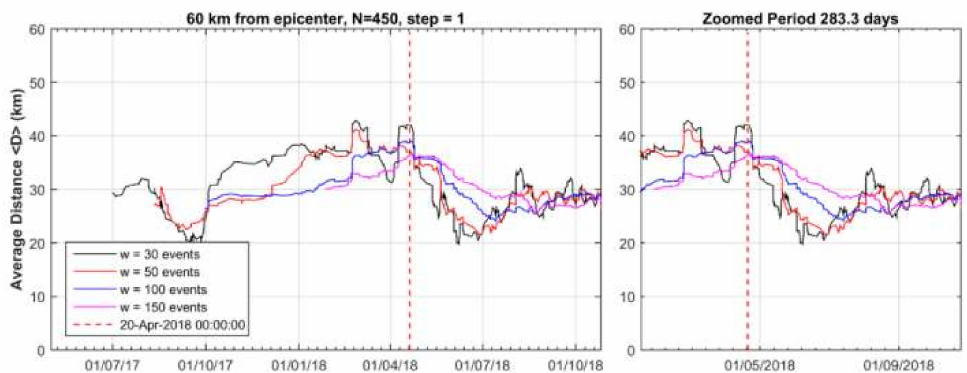
Figure 15. Variation of < D > for the BGS 2 background seismicity state (1 May 2017–20 April 2018) and the hypothetical foreshock activity (20 April 2018–25 October 2018, cluster 2). In each step < D > is calculated as the mean of w events. After 20 April 2018 (vertical red line) < D > dropped significantly with respect to the previous period (see Section 2.3).